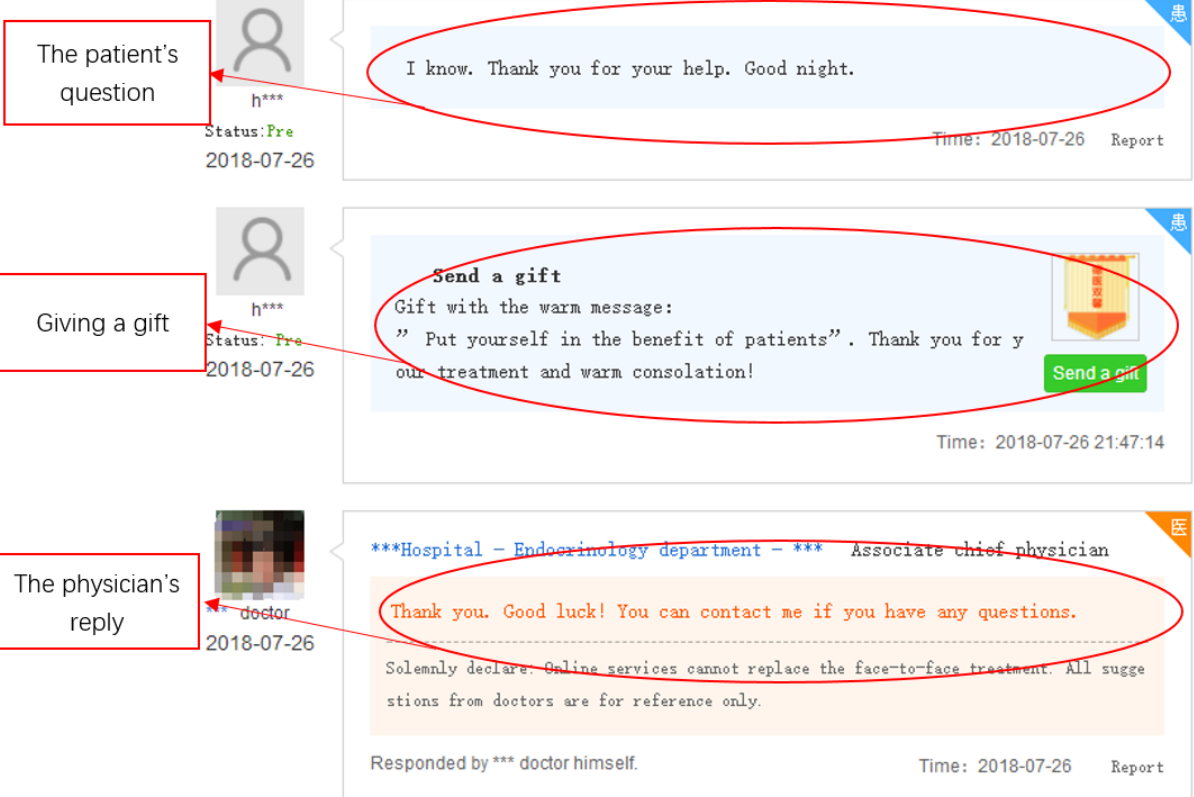
Figure 3. Physician-patient interaction